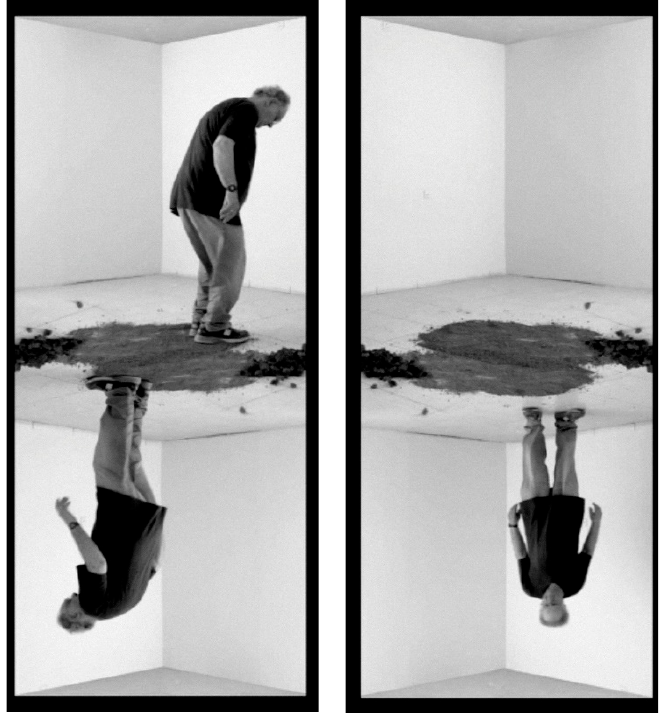
Figure 4. Ronen Sharabani, Card , 2014. Video.